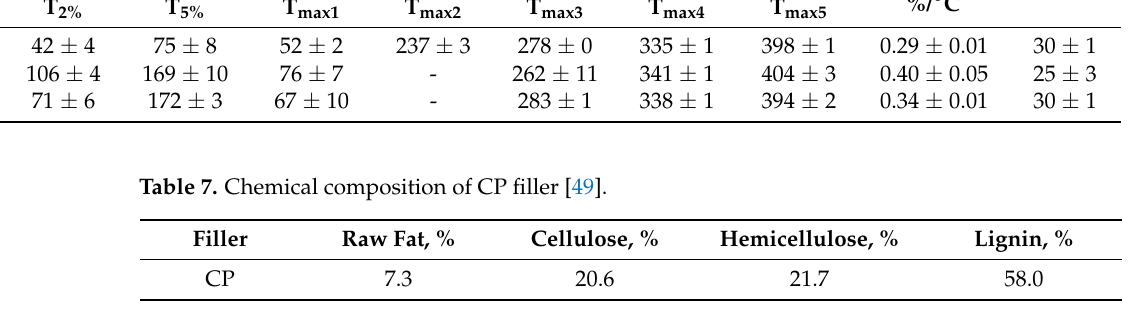
Table 7. Chemical composition of CP filler [49].